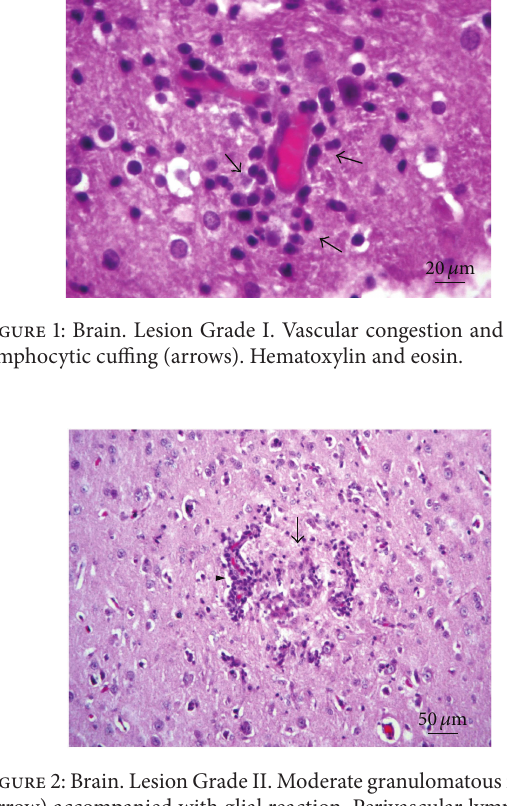
Figure 2: Brain. Lesion Grade II. Moderate granulomatous reaction (arrow) accompanied with glial reaction. Perivascular lymphocytic infiltrate (arrowhead). Hematoxylin and